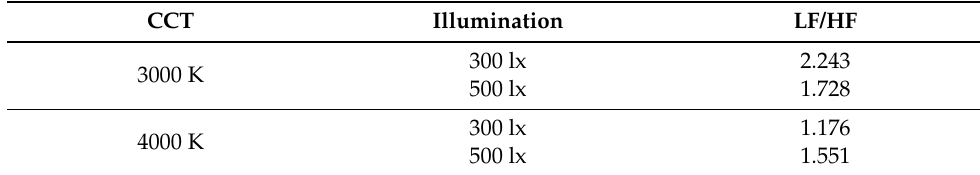
Table 9. Ratio of low frequency to high